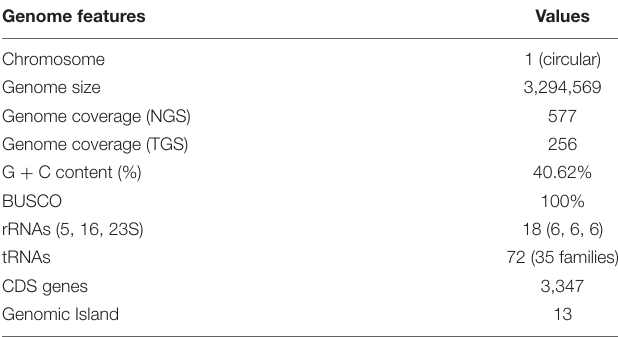
TABLE 2 | Genome features of strain DYY3.